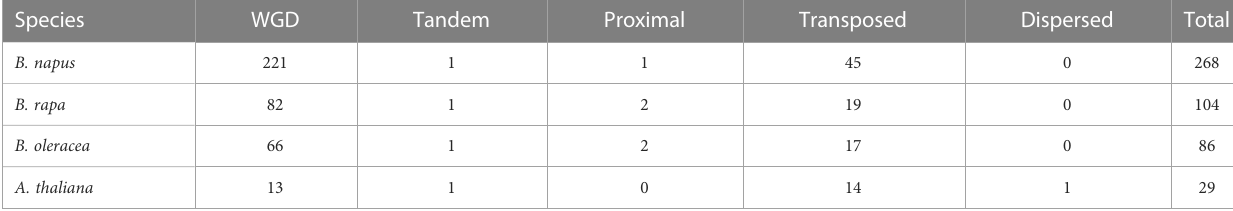
TABLE 1 The identi fi cation of duplicated type for UBC genes in B. napus and other three Brassicaceae species. Species WGD Tandem Proximal Transposed Dispersed Total